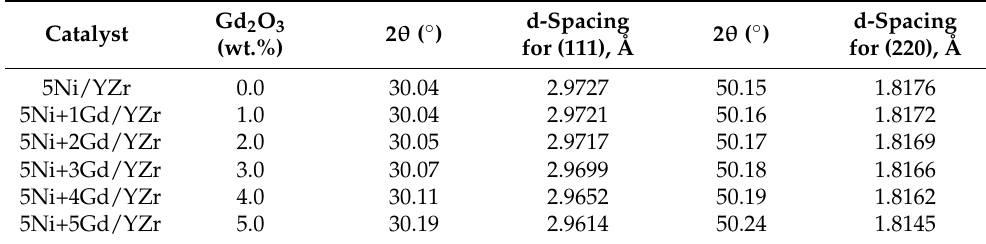
Table 2. The shift in the 2 θ angle and change in the d-spacing of (111) crystallographic planes of cubic yttria-stabilized zirconia phase for the fresh catalysts.